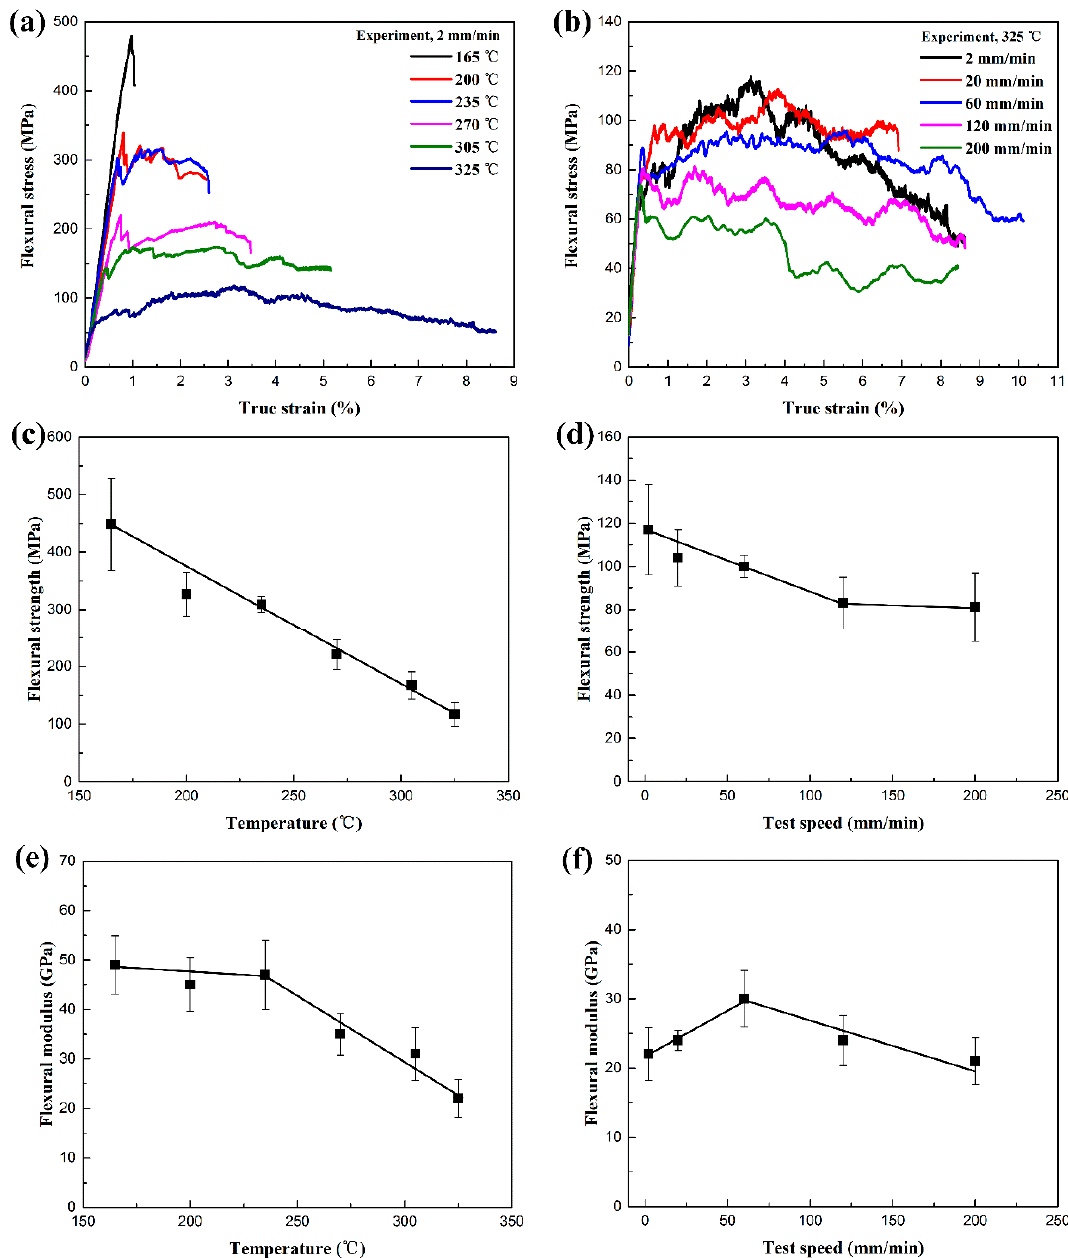
Figure 6. Flexural properties of woven CF/PEEK composites at different condition: ( a , b ) flexural stress-strain curve, ( c , d ) the relationship between flexural strength and temperature or speed, and ( e , f ) the relationship between flexural modulus and temperature or speed.